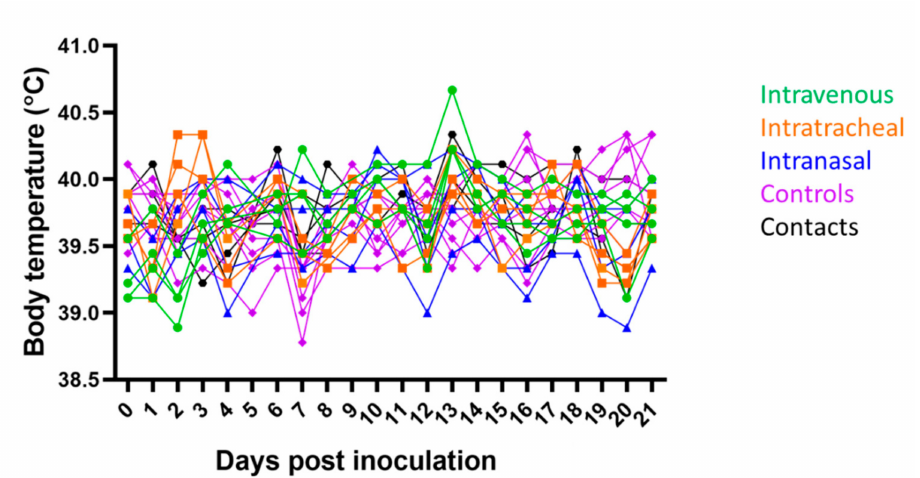
Figure 1. Daily pig body temperatures in degrees Celsius. Pigs inoculated intravenously are colored green, intratracheally orange, intranasally blue, controls purple, and contact pigs black.